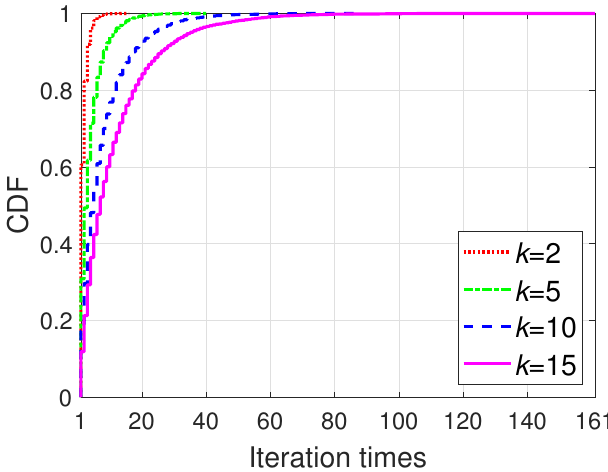
Figure 6. CDF of iteration times with different primary divisions.